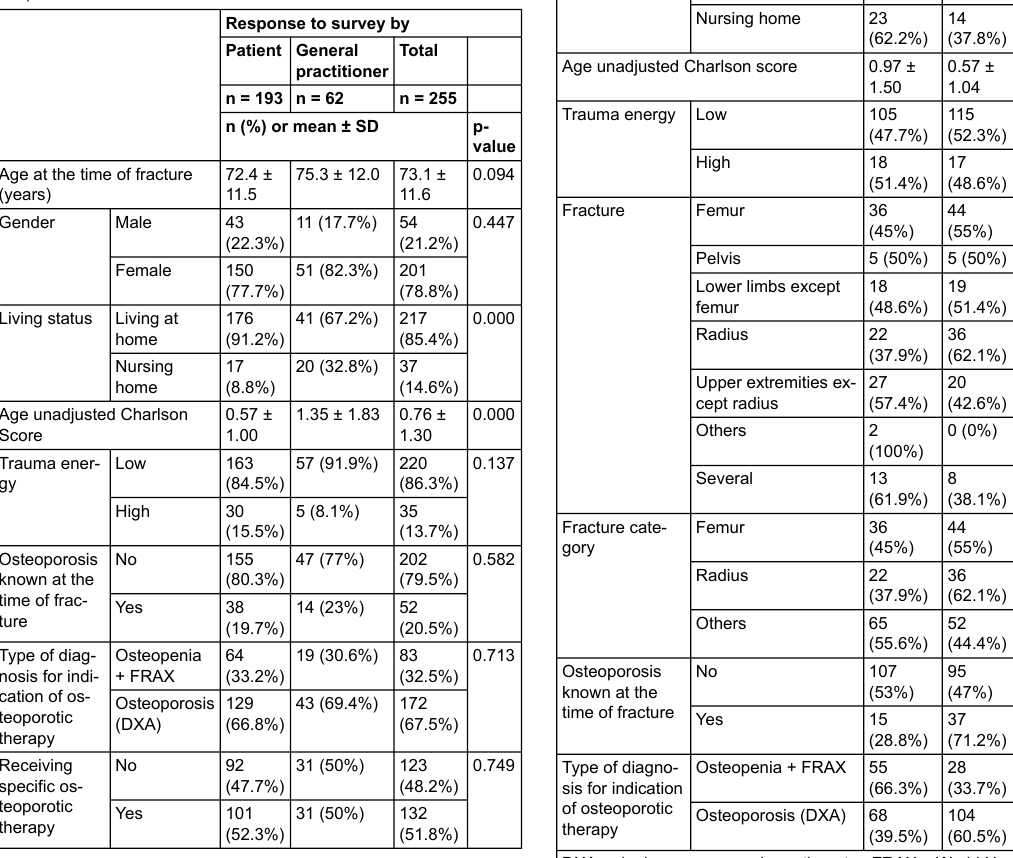
Table 1: Characteristics of patients who responded to the survey (n = 193) versus cases where only their general practitioner responded (n = 62).